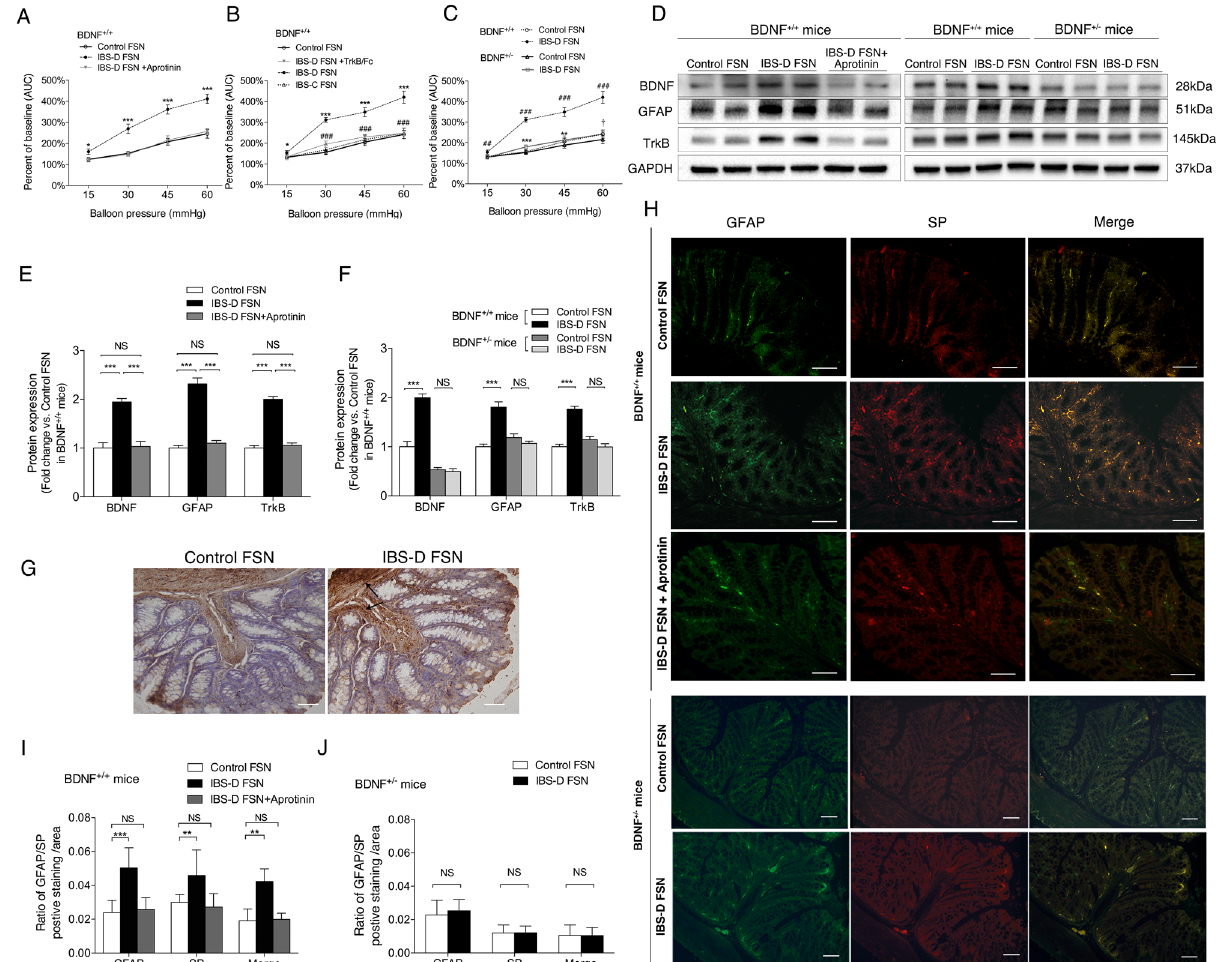
Figure 3. Alterations of visceral sensitivity and expressions of BDNF, GFAP and substance P in colon of BDNF +/+ and BDNF +/− mice in the presence or absence of IBS fecal supernatants (FSN) stimulation. ( A ) Intracolonic infusion of IBS-D FSN significantly increased electromyographic (EMG) activity of abdominal muscles in wild-type mice (*, IBS-D FSN vs. control). ( B ) TrkB/Fc significantly suppressed the effect of IBS-D FSN at 30, 45 and 60 mmHg (*, IBS-D FSN vs. control; #, IBS-D FSN vs. IBS-D FSN plus TrkB/Fc). ( C ) The overall response to the CRD after treatment by IBS-D FSN in BDNF +/− mice was significantly lower than that in BDNF +/+ mice. (*, IBS-D FSN vs. control FSN in BDNF +/− mice; #, IBS-D FSN in BDNF +/+ mice vs. in BDNF +/− mice; † control FSN in BDNF +/+ mice vs. in BDNF +/− mice). ( D – F ) Western blotting analysis of BDNF, GFAP and TrkB protein levels in colon of BDNF +/+ and BDNF +/− mice 4 h after intracolonic infusion with IBS-D FSN compared with control FSN or aprotinin-pretreated IBS-D FSN. ( G ) Overview of GFAP expression in the full-thickness colonic wall in BDNF +/+ mice 4 h after intracolonic infusion with IBS-D FSN compared with control FSN. Black arrow shows increased expression of GFAP in muscular layers. ( H ) Dual immunofluorescence staining of SP and GFAP in colon of BDNF +/+ and BDNF +/− mice 4 h after intracolonic infusion with IBS-D FSN compared with control FSN or aprotinin-pretreated IBS-D FSN. Co-immunostaining for colonic SP and GFAP was significantly increased in BDNF +/+ mice ( I ) but not in BDNF +/− mice ( J ) after 4-hour intracolonic incubation with IBS-D FSN. The results are displayed as the mean ± SD. ( * P < 0.05 ** P < 0.01, *** P < 0.001, ## P < 0.01, ### P < 0.001, † P < 0.05; AUC, area under curve; NS, not significant; target protein levels were normalized to GAPDH; n = 8 per group; scale bars: 50 μm). The gels were run under the same experimental conditions. Cropped gels/blots are presented. (Full-length gels/blots are shown in Suppl. Fig. S2 with indicated cropping